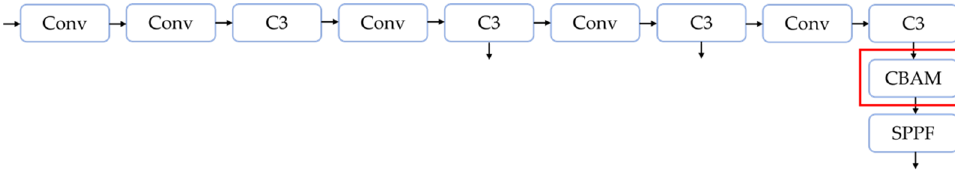
Figure 7. The structure of the CBAM module.